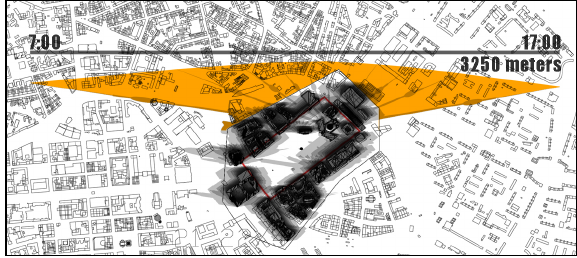
Figure 5. Range of shadow from Alexander Platz and Berlin